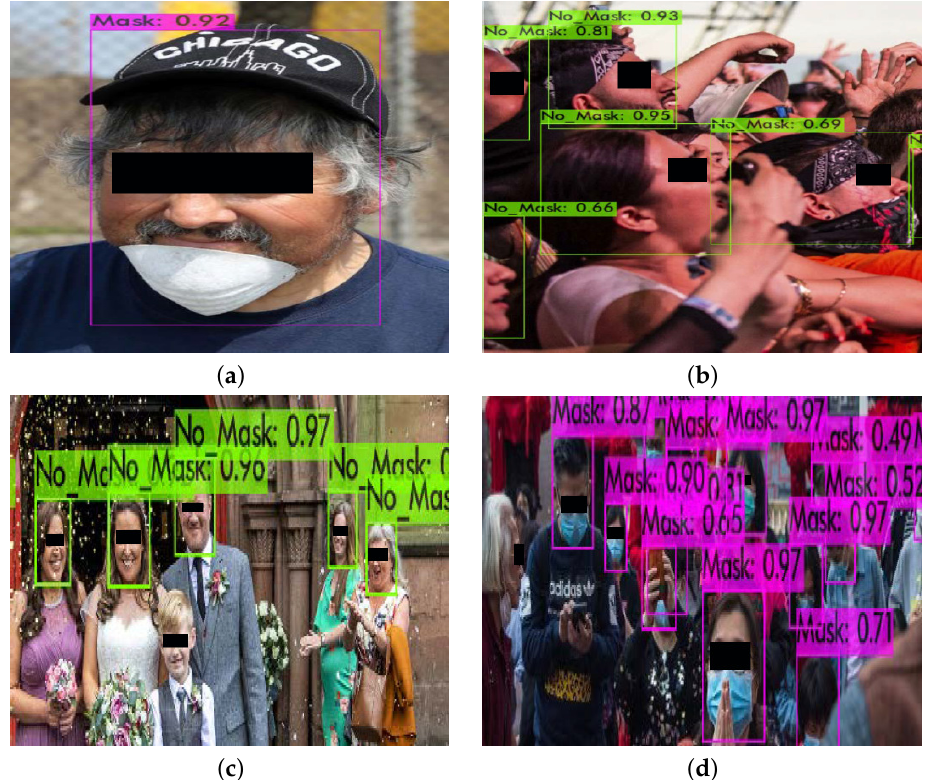
Figure 10. Classification failure cases. These images may contain ( a ) faces in which the mouth and the nose are uncovered, faces with ( b ) a neckband, ( c ) faces that are not detected, and ( d ) side faces at the border of the